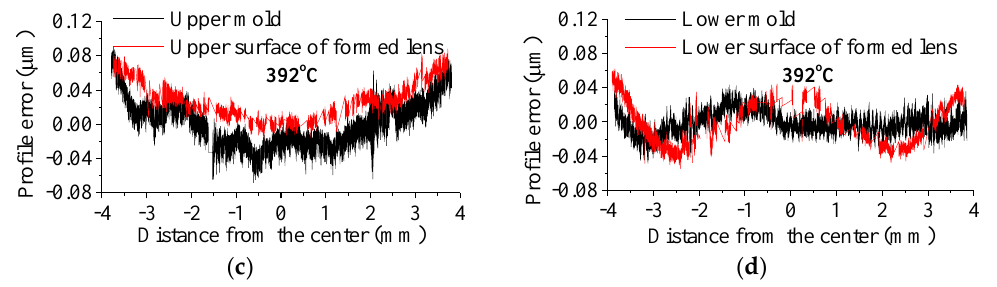
Figure 22. Evaluations of surface topography comparison of profile error: ( a ) between upper mold and lens formed at 382 °C, ( b ) between lower mold and lens formed at 382 °C, ( c ) between upper mold and lens formed at 392 °C, and ( d ) between lower mold and lens formed at 392 °C.